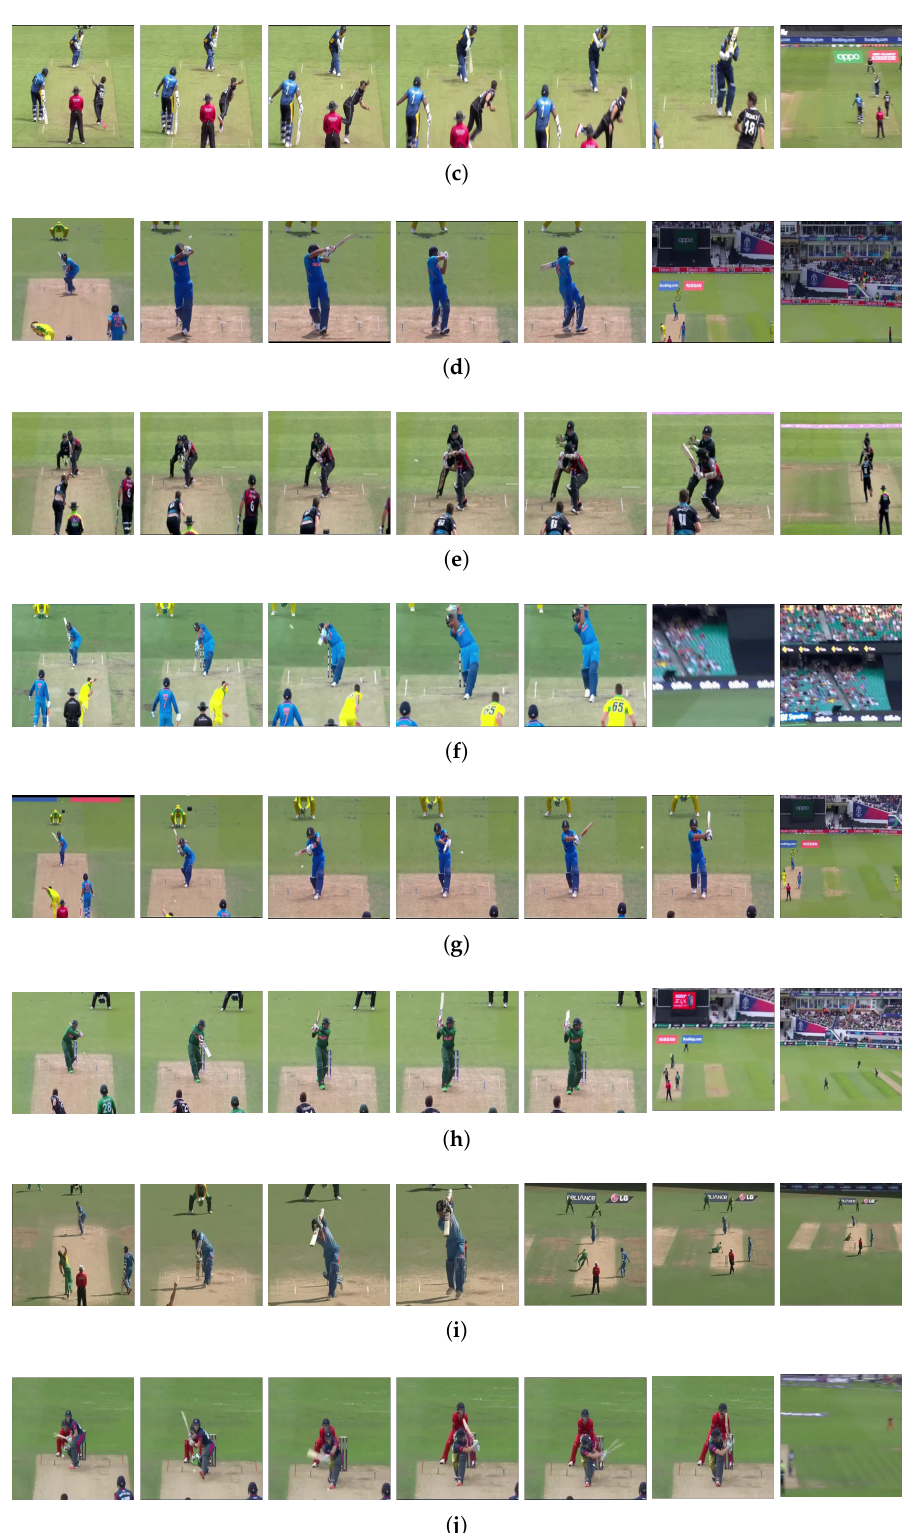
Figure 8. Sequential video frames for ( a ) cover drive, ( b ) defensive shot, ( c ) flick, ( d ) hook shot, ( e ) late cut, ( f ) lofted shot, ( g ) pull shot, ( h ) square cut, ( i ) straight drive, ( j ) sweep